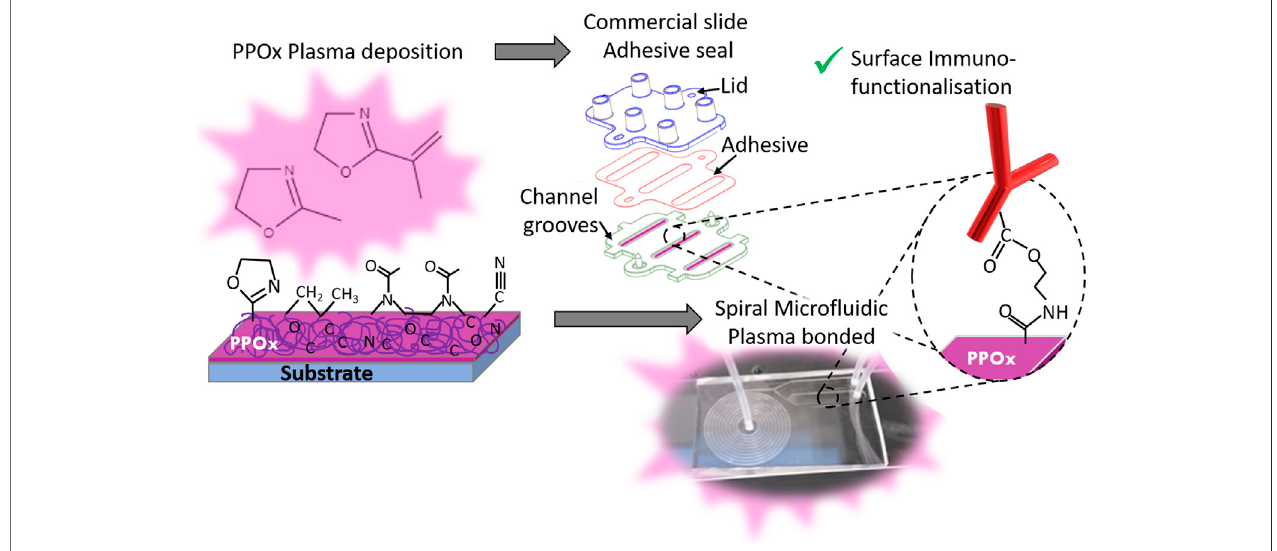
FIGURE 1 | Schematic of the biosensor preparation, showing the PPOx deposition step followed by the chip assembly -via adhesive seal for the commercial slide (top) orplasmabondingforthespiralmicro fl uidics (bottom) -andthePPOxsurfaceimmune-functionalisation.Thisoccursviaformationofanamideesterbondbetween the oxazoline ring and the carboxylic acid function of the